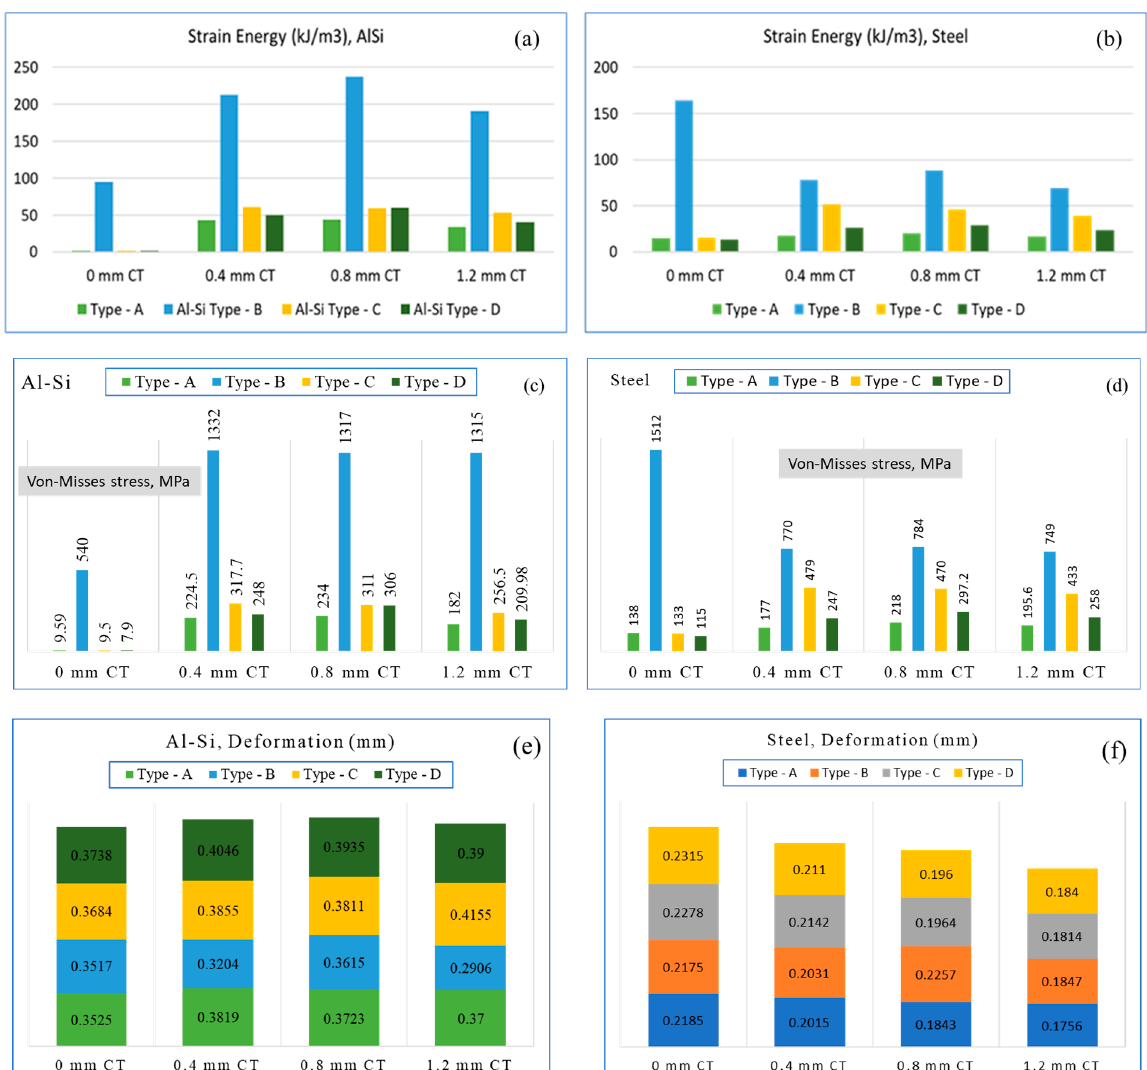
Figure 9. ( a – f ) Strain energy and interlinked parameters (von-Mises stress and elastic strain) response to piston design exchange and variable coating thicknesses.